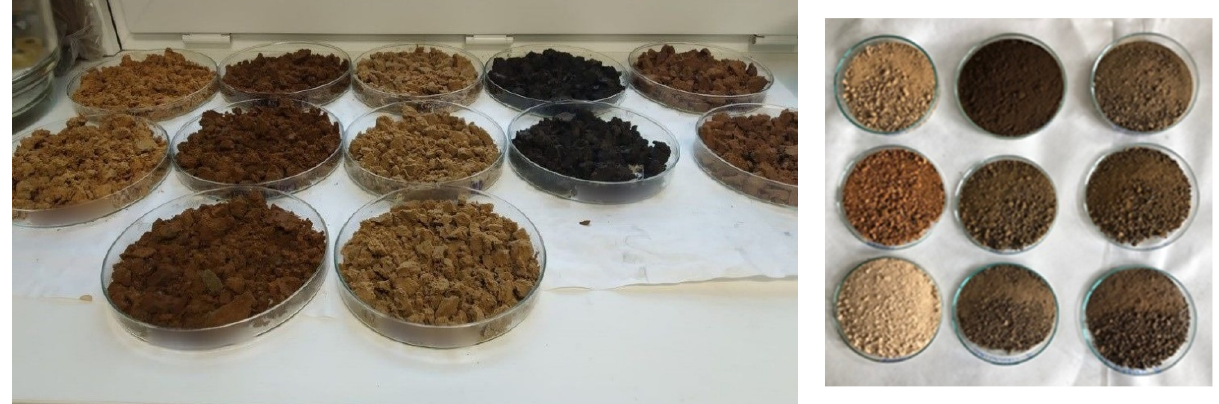
Figure 2. Preparation of samples for leaching—on the left: the delivered samples, on the right: sludge after milling and drying-up. Source: own.